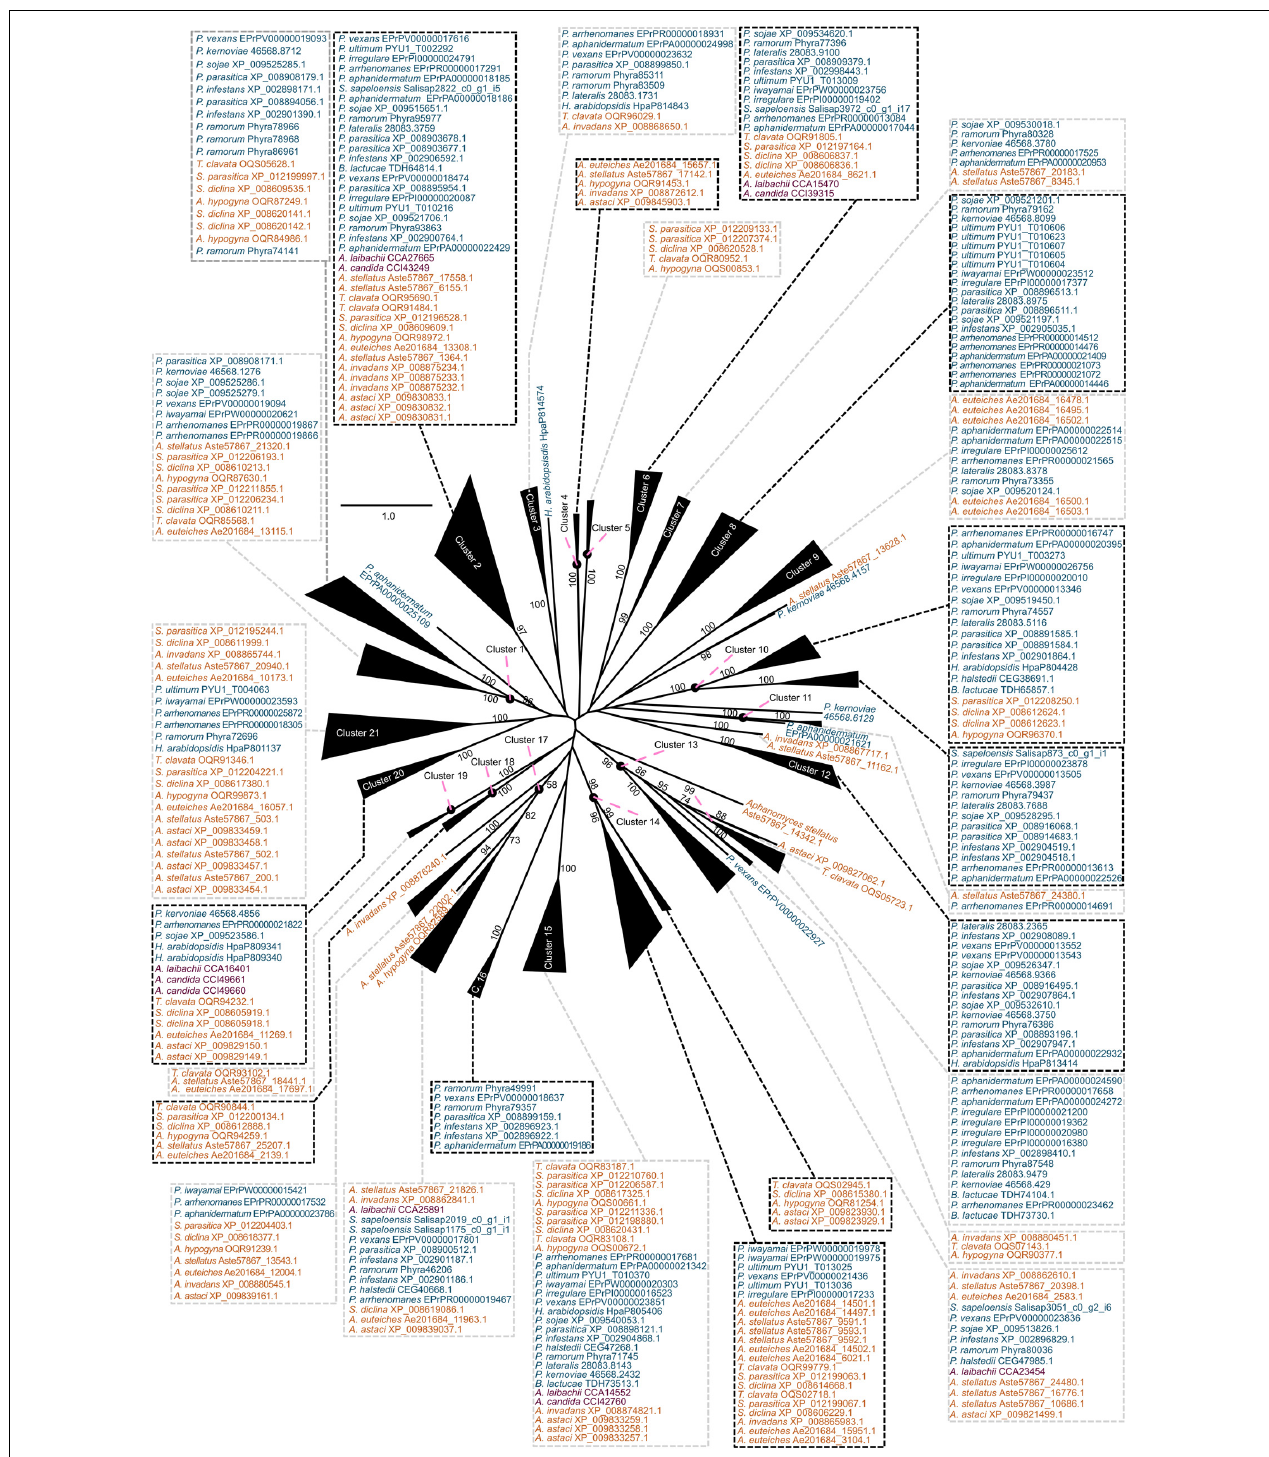
FIGURE 3 | Clustering of the carbohydrate esterase 1 (CE1) gene family in oomycetes utilizing a phylogenetic approach. A maximum likelihood phylogeny of 383 CE1 protein sequences mined from 25 oomycete genomes and the transcriptome of Salisapilia sapeloensis is shown. The tree was computed based on a G-INS-I alignment using IQ-TREE multicore version 1.6.12; ModelFinder was used to test 168 protein models, and WAG+I+G4 was chosen according to the Bayesian information criterion (BIC) as the best model. One hundred bootstrap replicates were computed. Only bootstrap values ≥ 50 are shown. Colors indicate the phylogenetic affiliation of the species: blue, Peronosporales; orange, Saprolegniales; purple, Albugonales. Classification into orders is based on McCarthy and Fitzpatrick (2017). Alignment is provided in Supplementary Dataset S1 .